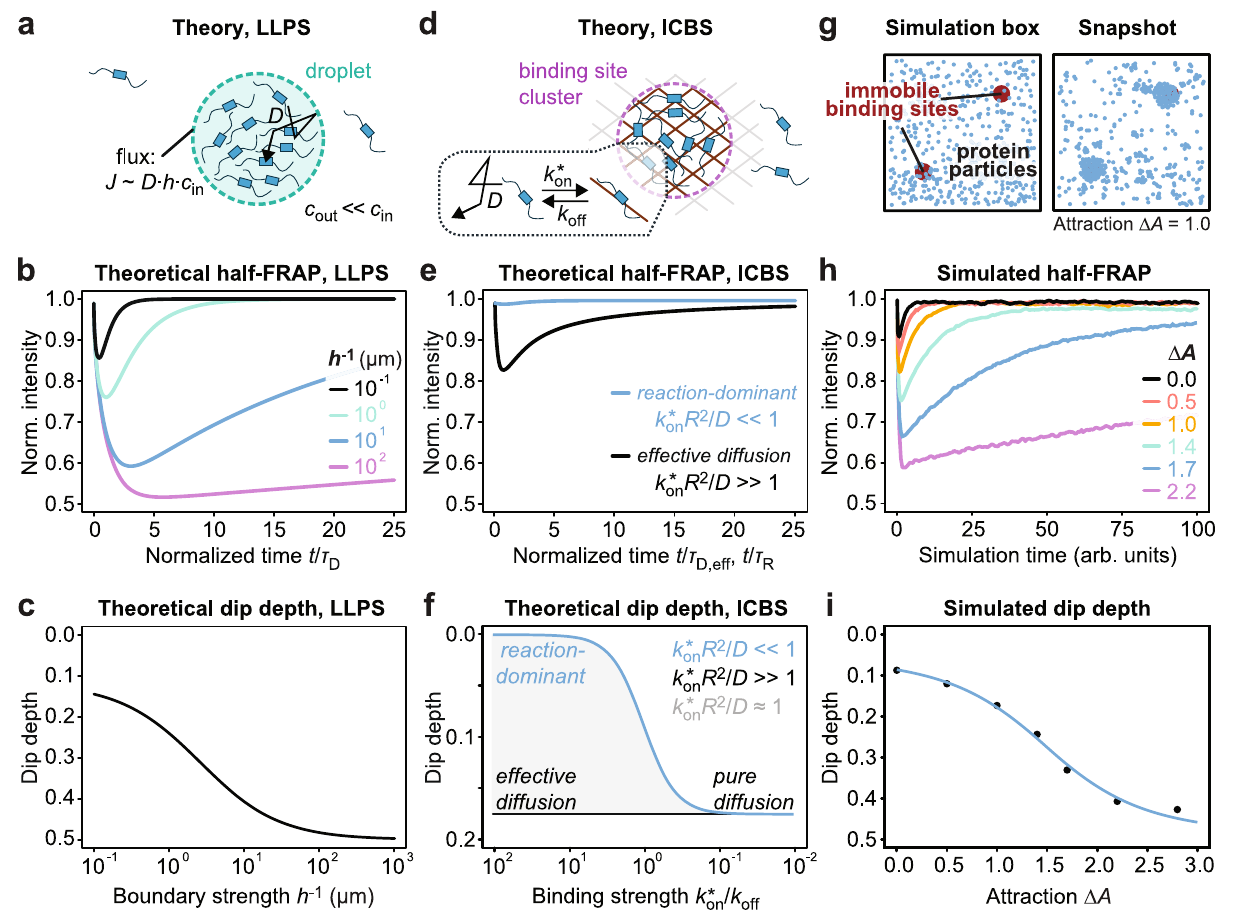
Fig. 3 | Theoretical and simulated half-FRAP curves relate the dip depth to the underlying molecular properties. a Model describing the LLPS scenario. The condensateinterfacewasmodeledasaboundarythatattenuatesthediffusive fl ux. b Theoretically predicted half-FRAP curves in the non-bleached half for the LLPS model. The curves are plotted versus time divided by the characteristic diffusion time τ D = R 2 /4 D , showing that the dip depth is independent of the diffusion coef- fi cient D andcondensateradius R . c Relationshipbetweendip depthand boundary strength h − 1 in the LLPS model. d Model describing the ICBS scenario. The binding reactionwasmodeledasapseudo fi rst-orderreactionwithrates k * on and k off ,where each particle could interact with only one binding site at a time. e Theoretically predicted half-FRAP curves in the non-bleached half for the ICBS model. For fast binding ( k * on R 2 / D » 1), the model converges to a pure diffusion model with an effective diffusion coef fi cient D eff = D /(1+ k * on / k off ). For strong and slow binding ( k * on R 2 / D « 1), it converges to a reaction-dominant model in which the recovery is